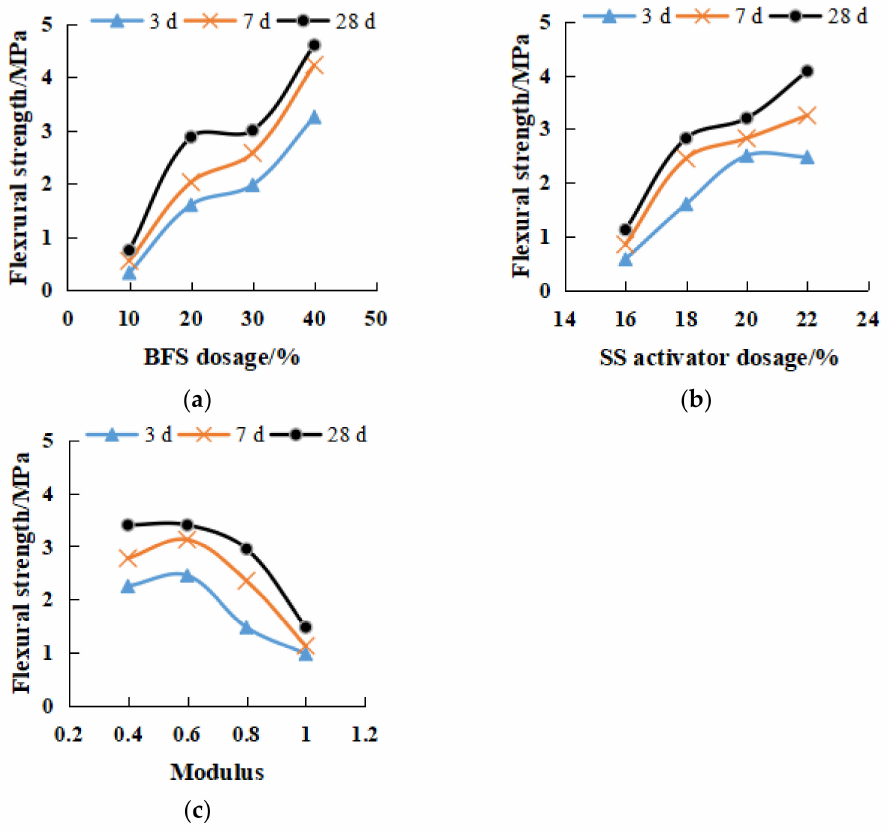
Figure 7. Influence of various factors on flexural strength. ( a ) different dosage of BFS ( b ) different dosage of SS activator ( c ) different